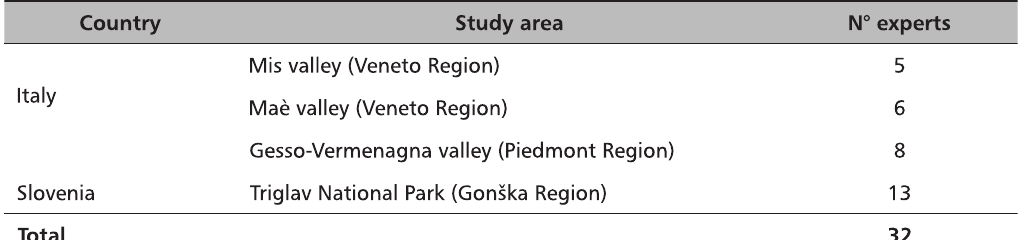
TABle 1. Number of experts interviewed subdivided per study